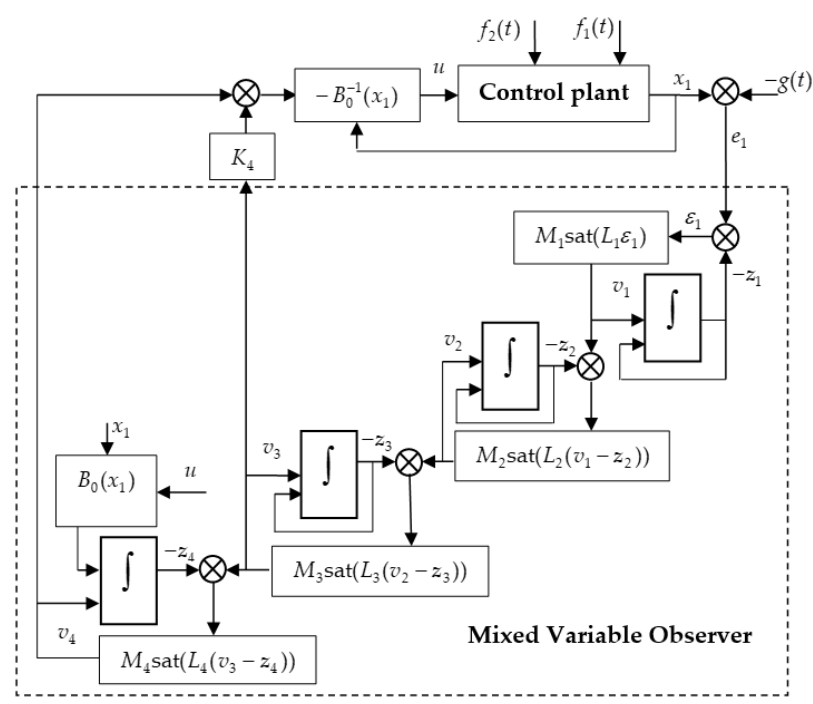
Figure 1. Block diagram of closed-loop system (1), (2), (29).